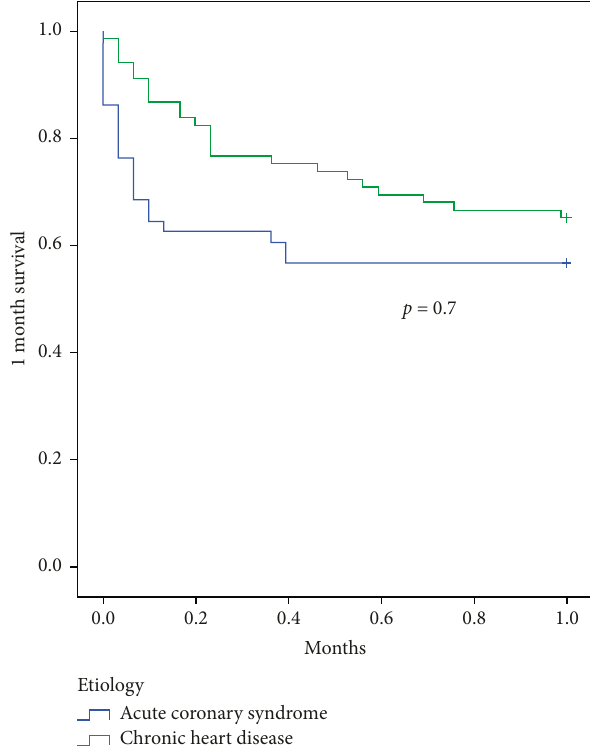
Figure 2: Comparison of Kaplan–Meier survival curves between CS related to ACS and CHF at 1 month. This analysis shows a similar mortality during the first month post-CS between the 2